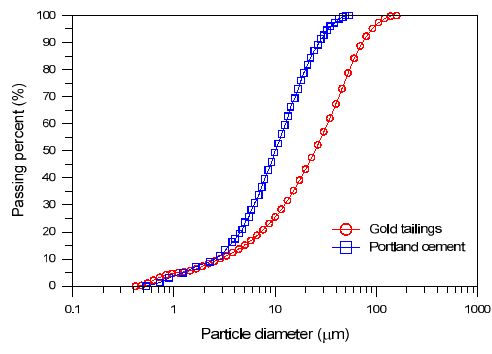
Figure 1. Particle size distribution of materials studied.